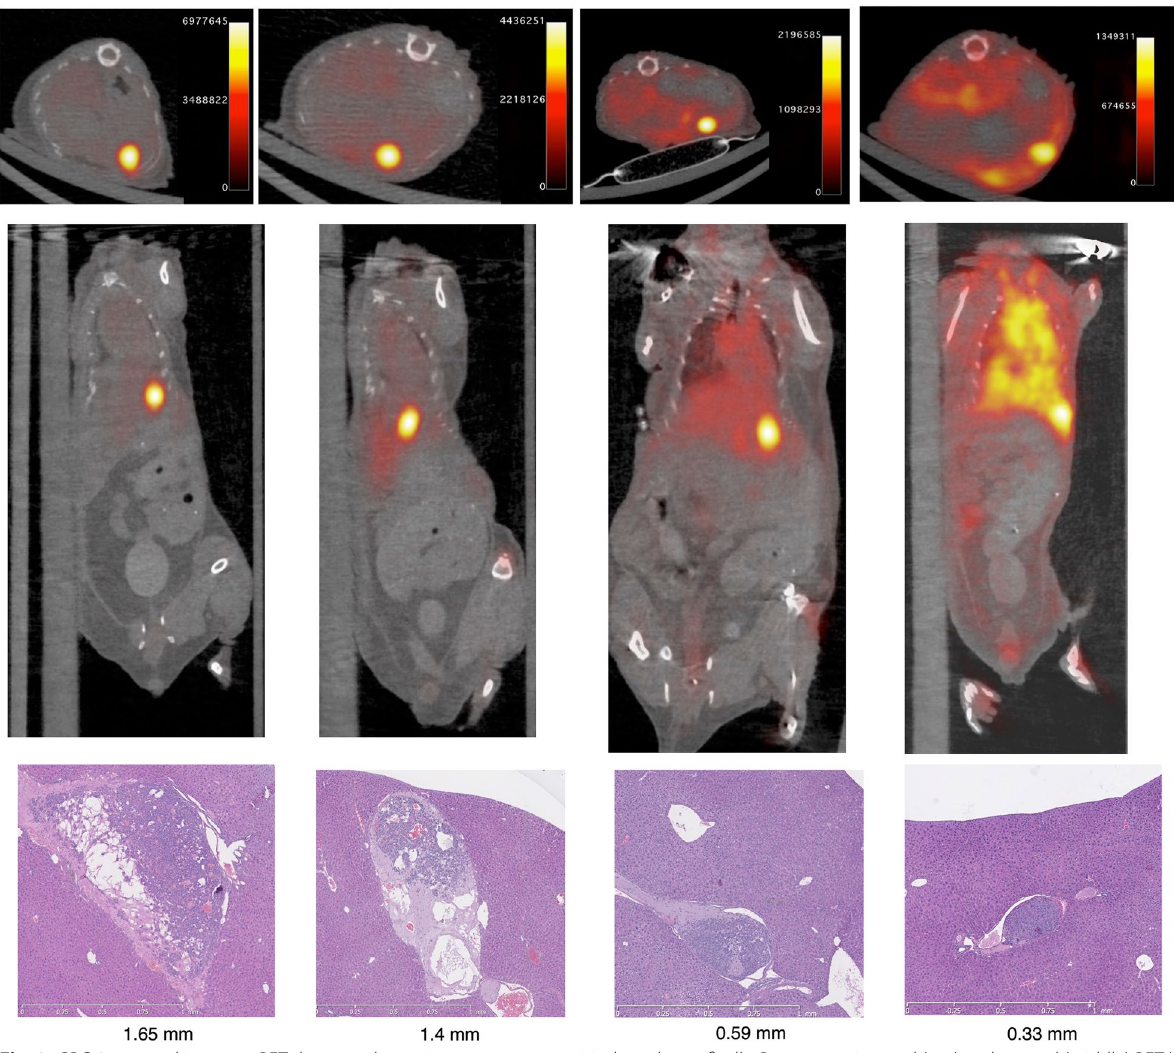
Fig. 3 GPC-3 targeted immuno-PET detects sub-centimeter tumors sensitively and specifically. Representative axial (top) and coronal (middle) PET/ CT-fused images of tumor-bearing animals 4 days after injection with 89 Zr-aGPC3. Hematoxylin and eosin-stained hepatic tissue containing tumor corresponding to 89 Zr-aGPC3 avid tumor (bottom). Maximum histologic cross-sectional diameter listed